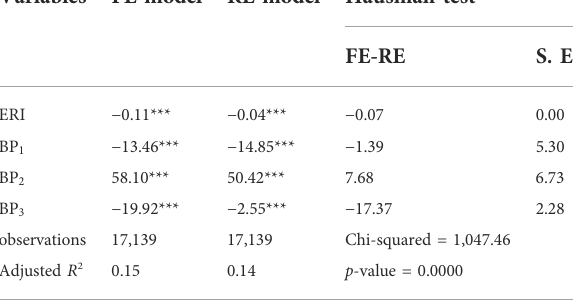
TABLE 4 Hausman test